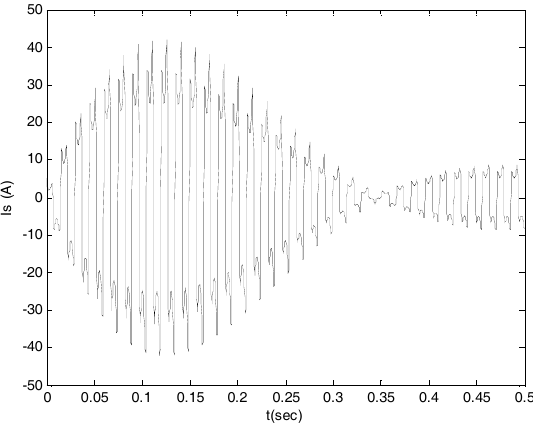
Figure 15. A computer simulation of IG with L s = 0.2 H.